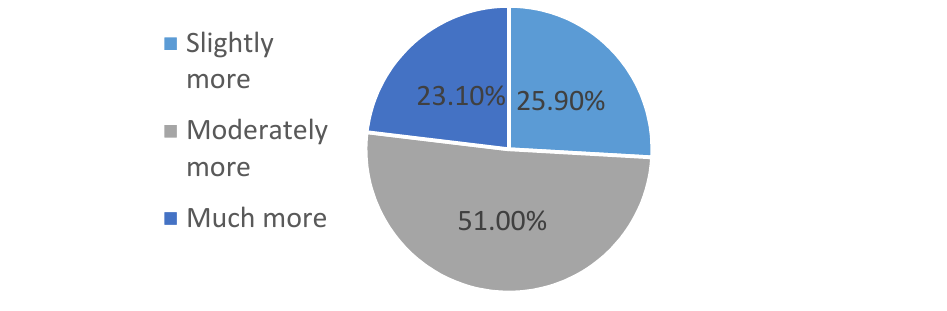
Figure 3. Amount of extra food purchased among participants who reported stockpiling.